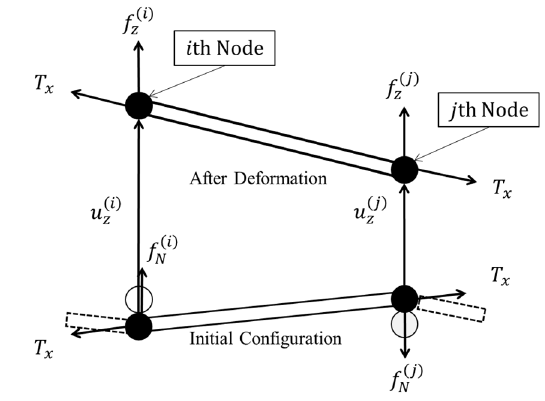
Figure 2. Deformation of string element in out-of-plane direction of string bed.